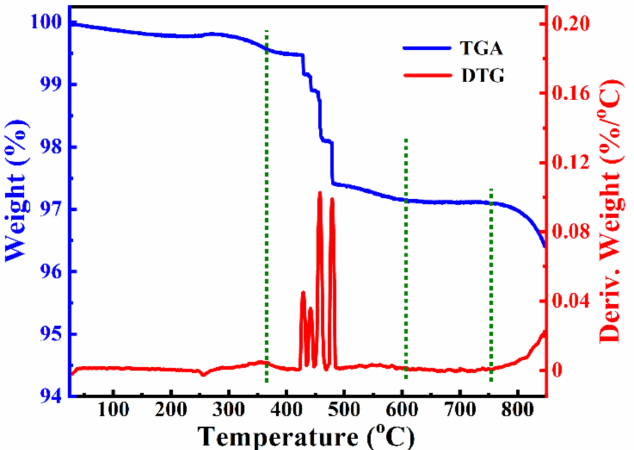
Figure 1. Thermogravimetric–differential analysis (TGA–DTG) measurement of pre-mixed precursor (black powder with additional 10 times NaCl in weight ratio) at a heating rate of 10 ◦ C/min in air atmosphere.